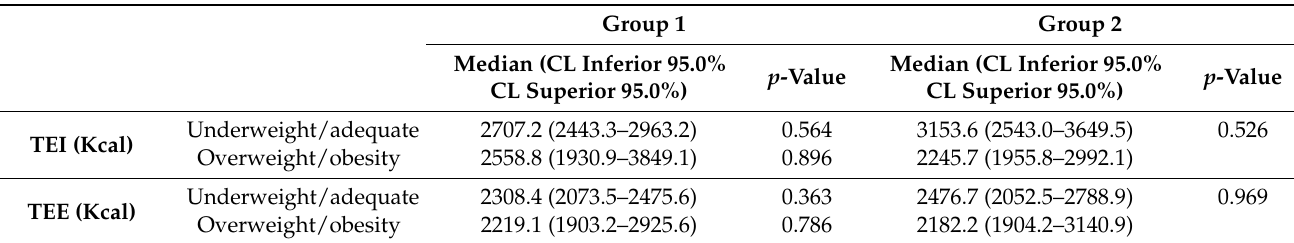
Table 3. Total energy intake and total energy expenditure comparison between groups and underweight/adequate weight and overweight/obese